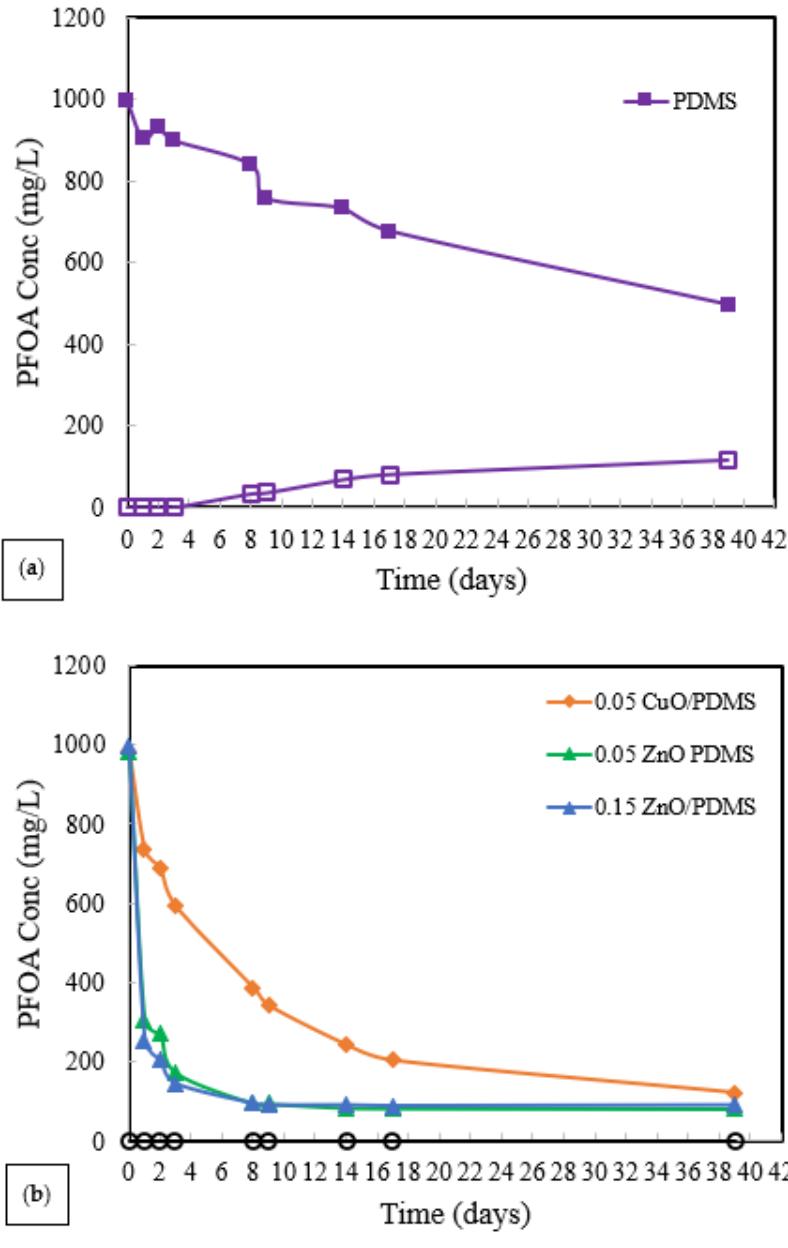
Figure 9. PFOA concentrations in aqueous solutions in membrane test systems. ( a ) PDMS membrane. ( b ) ZnO-PDMS, CuO-PDMS membranes. The closed symbols represent the PFOA concentrations on the left-hand side of the test system, which initially contained 1000 mg/L PFOA in 100 mL DI water. The open symbols represent the PFOA concentrations in the DI water on the right-hand side of the test system, which initially contained pure DI water. The masses of the membranes were approximately 3.5 g.